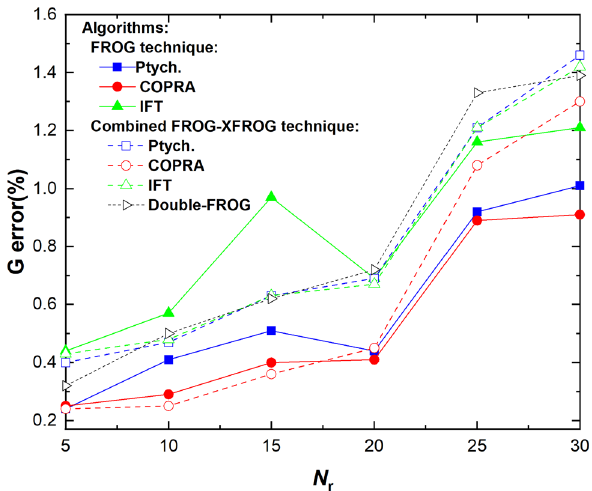
Figure 5. G error versus the number of random phase guide points N r from 5 to 30, for the FROG (solid lines, solid symbols) and the combined FROG–XFROG techniques (dashed lines, open symbols) using different algorithms: Ptychographic, COPRA, IFT, and Double-FROG. The lines serve only as a guide to the